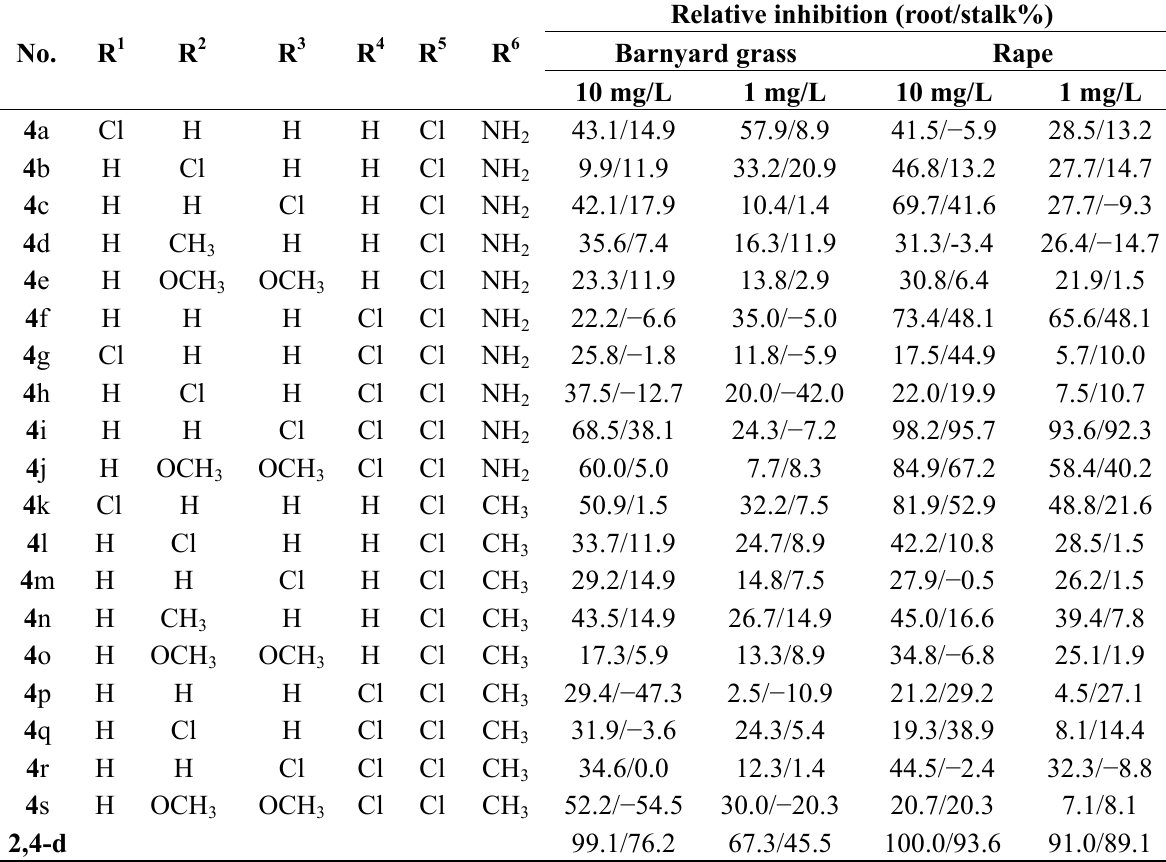
Table 2. The percent inhibitory ratios against the growth of root and stalk of barnyardgrass and rape at different dosage concentrations of 2-phenoxy-3 H -quinazolin-4-ones 4